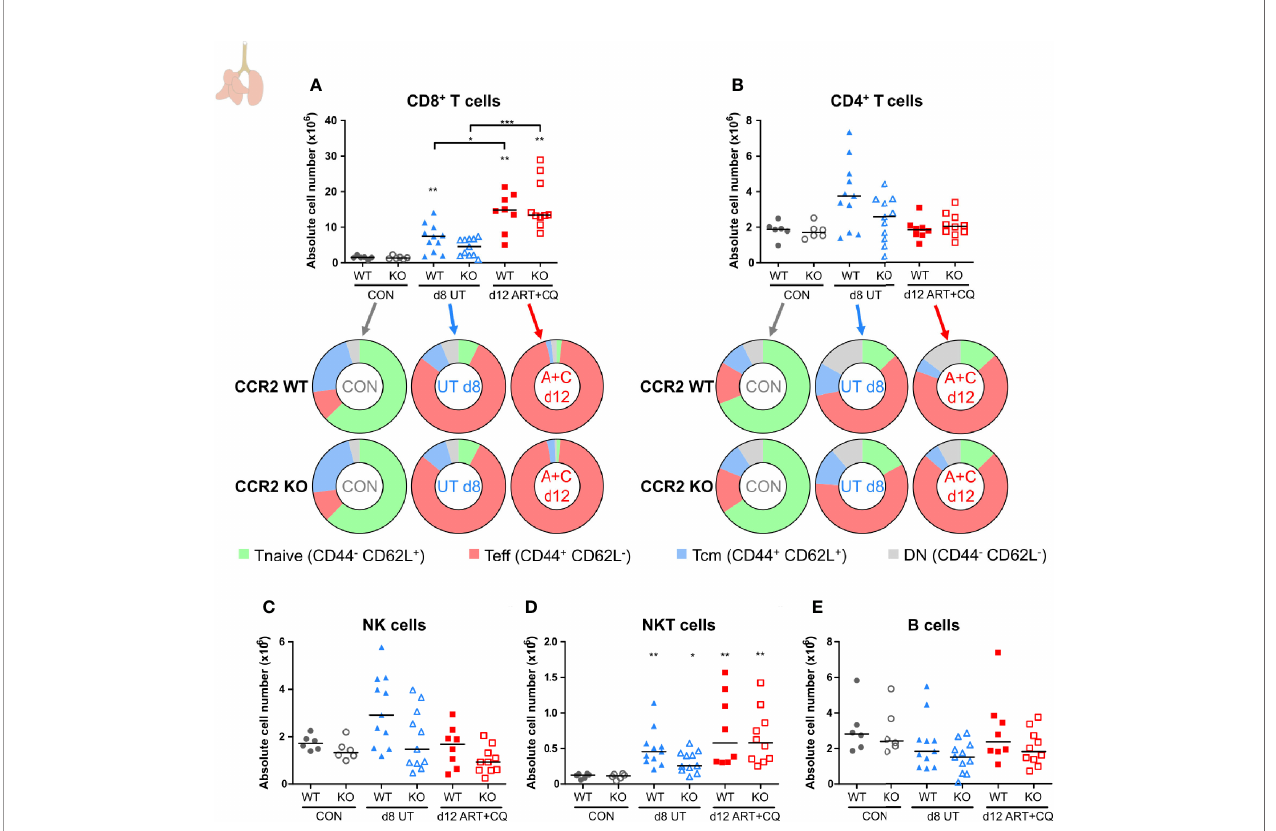
FIGURE 8 | CCR2 knock-out does not affect the number of pulmonary lymphocytes. CCR2 WT and CCR2 KO C57BL/6 mice were infected with Pb NK65. Mice were injected daily from 8 until 12 days p.i. with 10 mg/kg ART + 30 mg/kg CQ. Mice were dissected at the indicated days p.i. Leukocytes were isolated from the lungs according to protocol 2 and fl ow cytometry was performed. (A, B) The absolute numbers of CD8 + T cells (CD45 + CD3 + NK1.1 − CD8 + ) and CD4 + T cells (CD45 + CD3 + NK1.1 − CD4 + ) and the proportions of Tnaive (CD44 − CD62L + ), Teff (CD44 + CD62L − ), and Tcm (CD44 + CD62L + ) of the total cell population are shown. Percentages of these subsets are shown in Supplementary Figure 13 . (C – E) The absolute numbers of NK cells (CD45 + CD3 − NK1.1 + ), NKT cells (CD45 + CD3 + NK1.1 + ), and B cells (CD45 + CD3 − NK1.1 − B220 + ) were calculated. Compilation of two experiments. Each symbol represents data of an individual mouse. n=6 for CON CCR2 WT, n=6 for CON CCR2 KO, n=11 for UT CCR2 WT, n=11 for UT CCR2 KO, n=8 for ART+CQ CCR2 WT, n=10 for ART+CQ CCR2